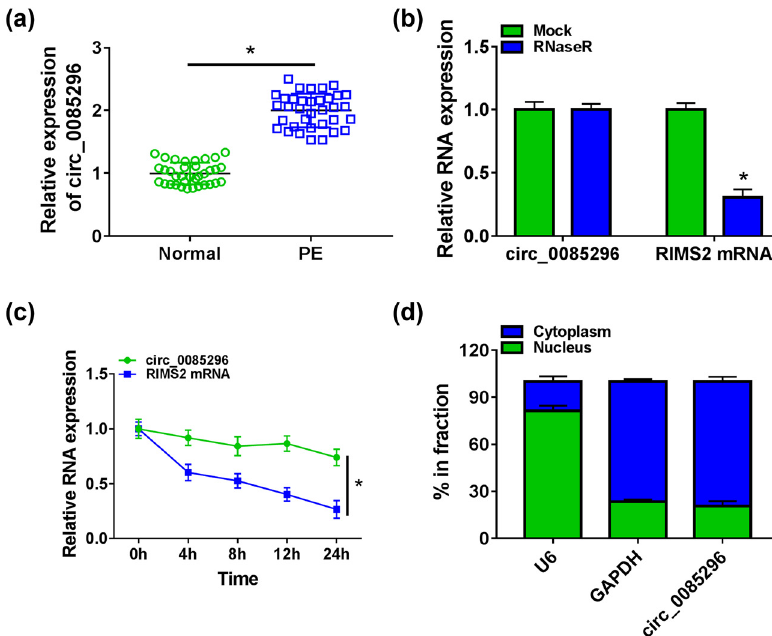
Figure 1: circ_0085296 expression was increased in PE patients. ( a ) The expression of circ_0085296 in the placental tissues of PE patients and normal pregnant women was measured by qRT - PCR. RNase R assay ( b ) and ActD assay ( c ) were performed to evaluate the circular characteristics of circ_0085296. ( d ) Subcellular localization assay was performed to assess the distribution of circ_0085296 in the cytoplasm and nucleus of HTR8/SVneo cells. * P <